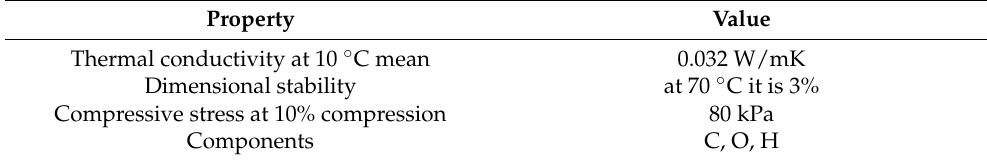
Table 1. The declared values of the tested graphite EPS by the